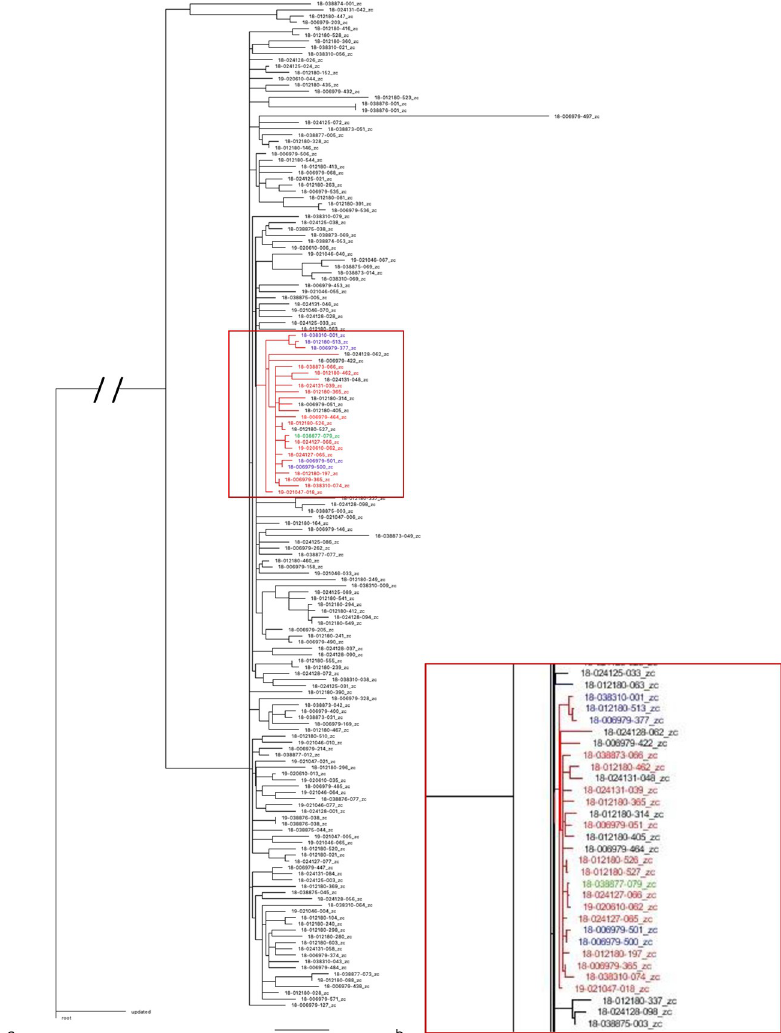
Fig 2. Phylogenetic tree of S . Dublin isolates. a) All isolates. b) NY isolates (in red) showing a common relationship on a single branch. Other isolates from northest region are colored (PA isolates in blue and MD isolates in